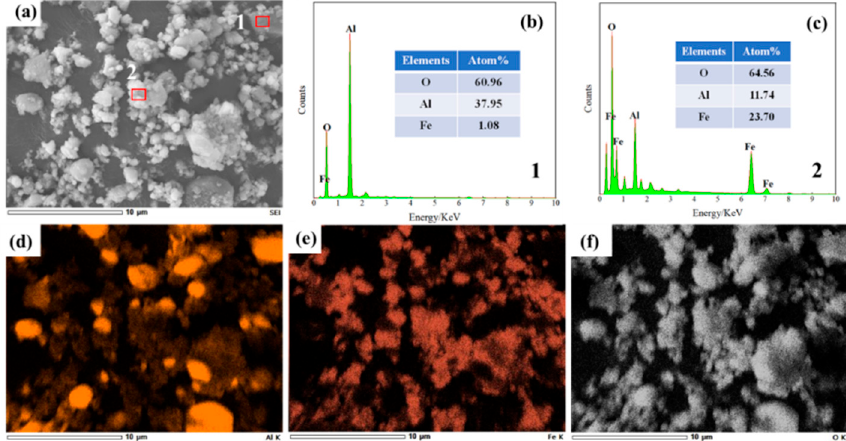
Figure 6. The SEM images of S 1 (mFe 2 O 3 /mAl 2 O 3 = 1:1) in ( a ), point spectrum for 1 in ( b ), point spectrum for 2 in ( c ), and the EDS spectrum of Fe in ( d ), Al in ( e ), and O in ( f ) at 2.3 V, 850 °C, and 4 h.